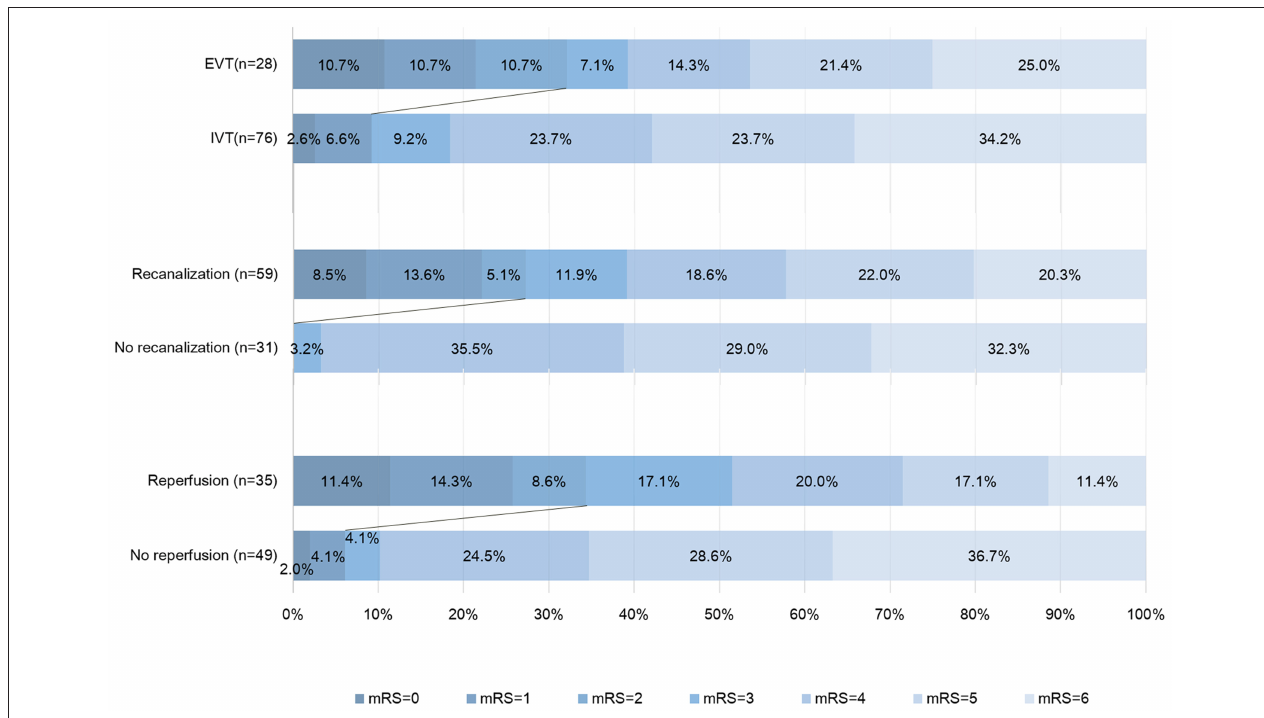
FIGURE 2 | Distribution of modified Rankin Scale score (mRS) at 90 days. This figure showed the 90-day scores on the modified Rankin scale for the patients in different groups. Scores range from 0 to 6, with 0 indicating no symptoms, 1 no clinically significant disability (able to carry out all usual activities, despite some symptoms), 2 slight disability (able to look after own affairs without assistance but unable to carry out all previous activities), 3 moderate disability (requires some help but able to walk unassisted), 4 moderately severe disability (unable to attend to bodily needs without assistance and unable to walk unassisted), 5 severe disability (requires constant nursing care and attention, bedridden, and incontinent), and 6 death. Persons with a score of 0, 1, or 2 are considered to have good outcome. IVT, intravenous thrombolysis; EVT, endovascular treatment.